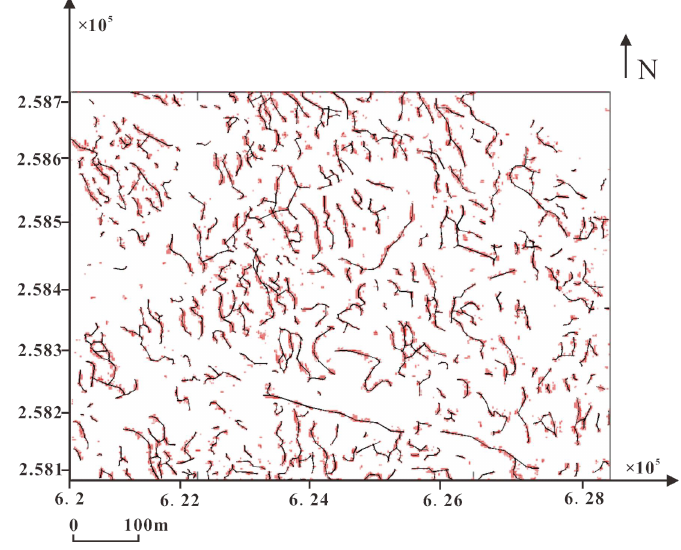
Figure 11. Linear prime connection (artificial).